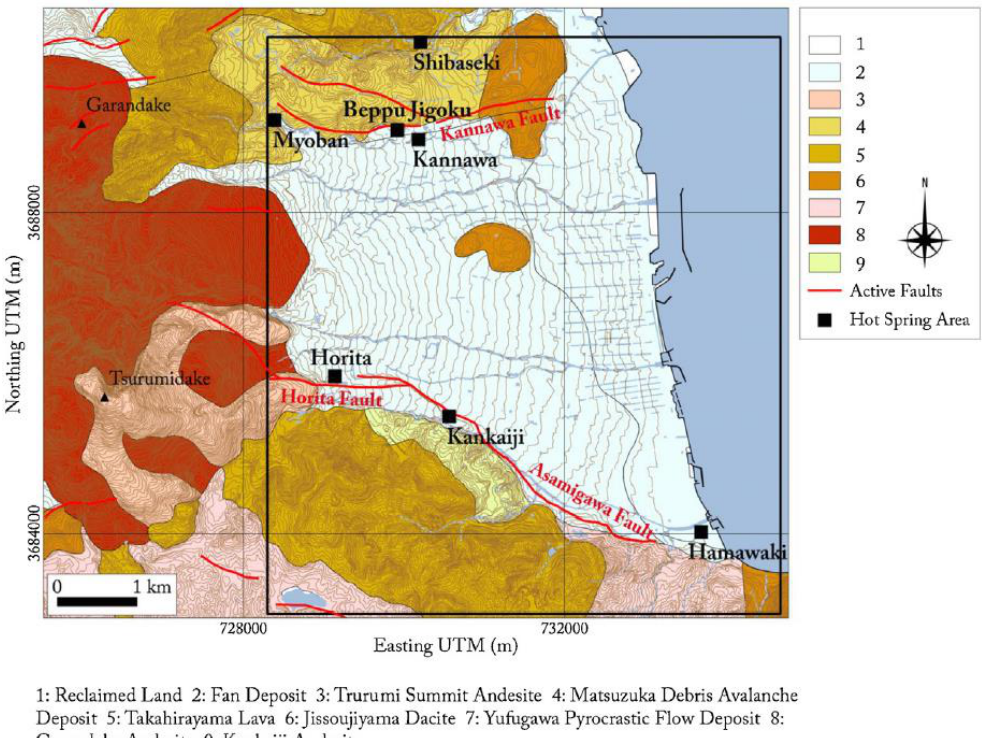
Figure 2. Geological map of the study area (modified after [6]).